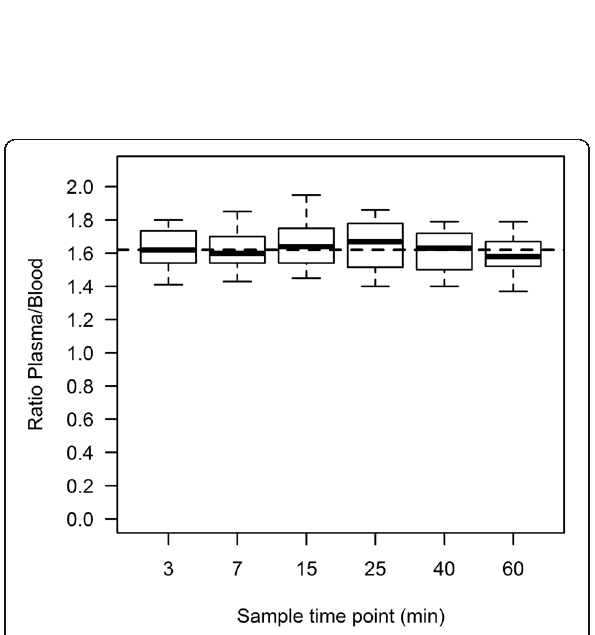
Fig. 2 Box plot of the plasma-to-blood ratio over time. The dashed line indicates the overall mean plasma-to-blood ratio of 1.62 ( n = 83)